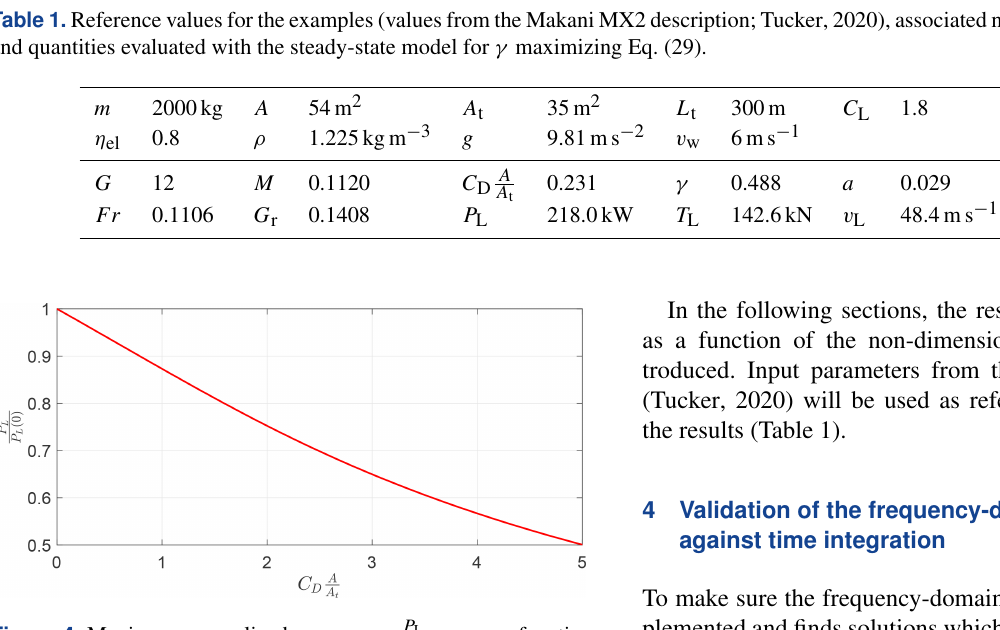
Figure 4. Maximum normalized power P L of C D A for high glide ratios G A t